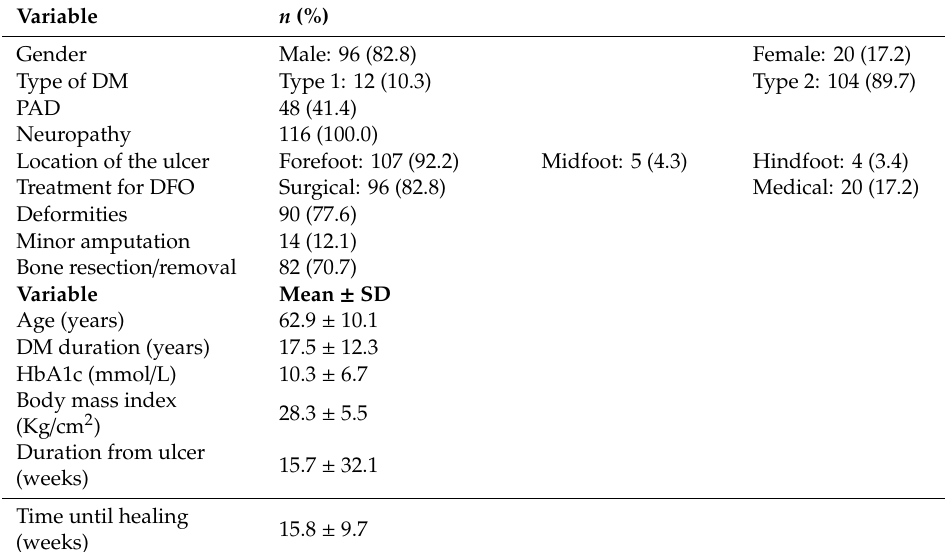
Figure 1. Flow chart of distribution of complications. Abbreviation: DFO, diabetic foot osteomyelitis. Table 1. Baseline characteristics of the patients.